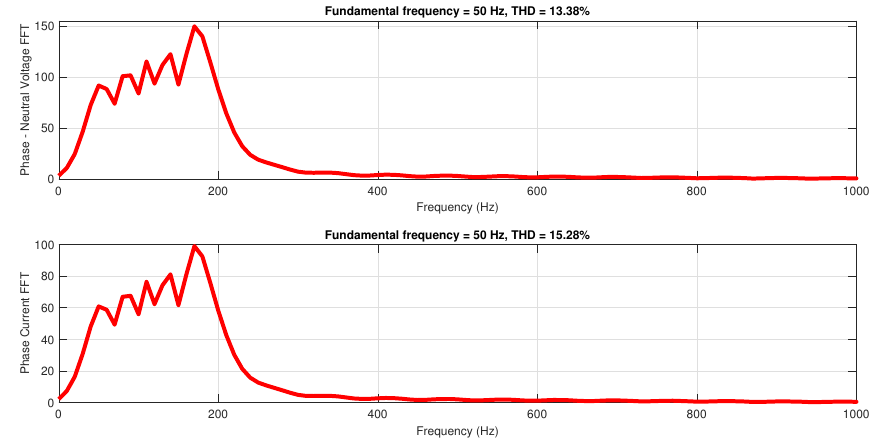
Figure 15. FFT analysis of 3-phase output voltage and current